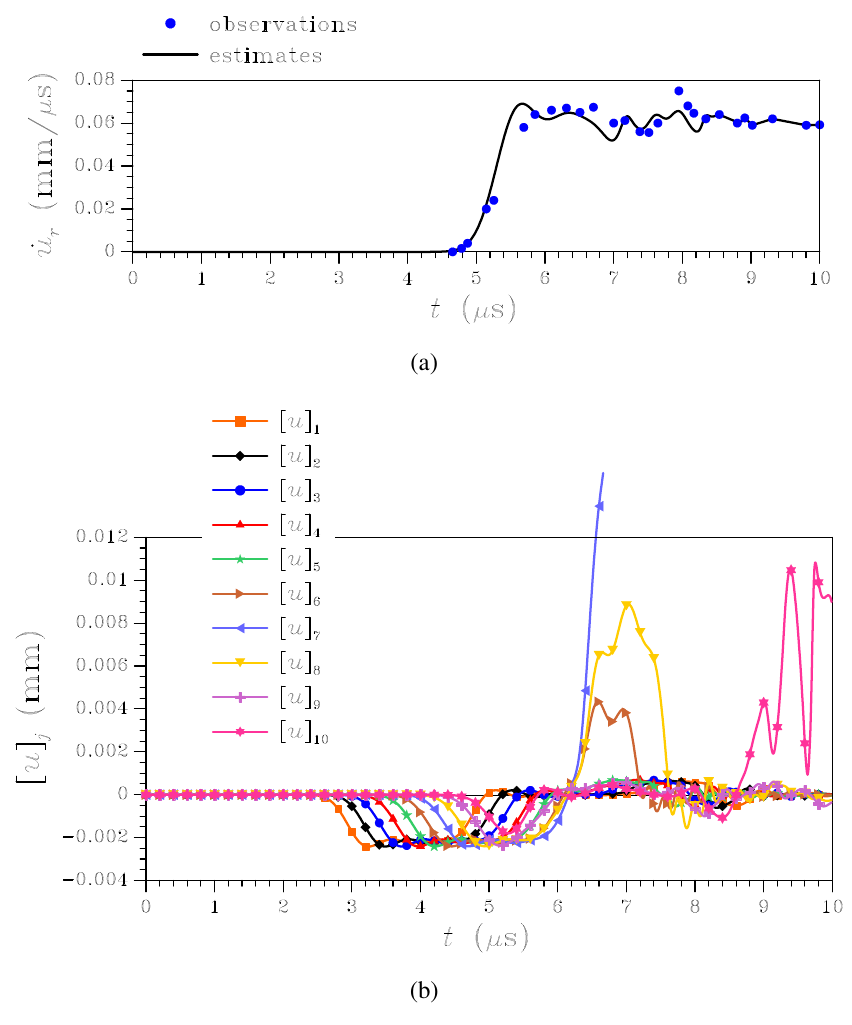
Figure 8. Impact on a 11+11-layer composite [14]: (a) comparison between experimental and tracked free surface velocity records; (b) estimated values of inter-laminar openings [ u ] j = 1 , ..., 10